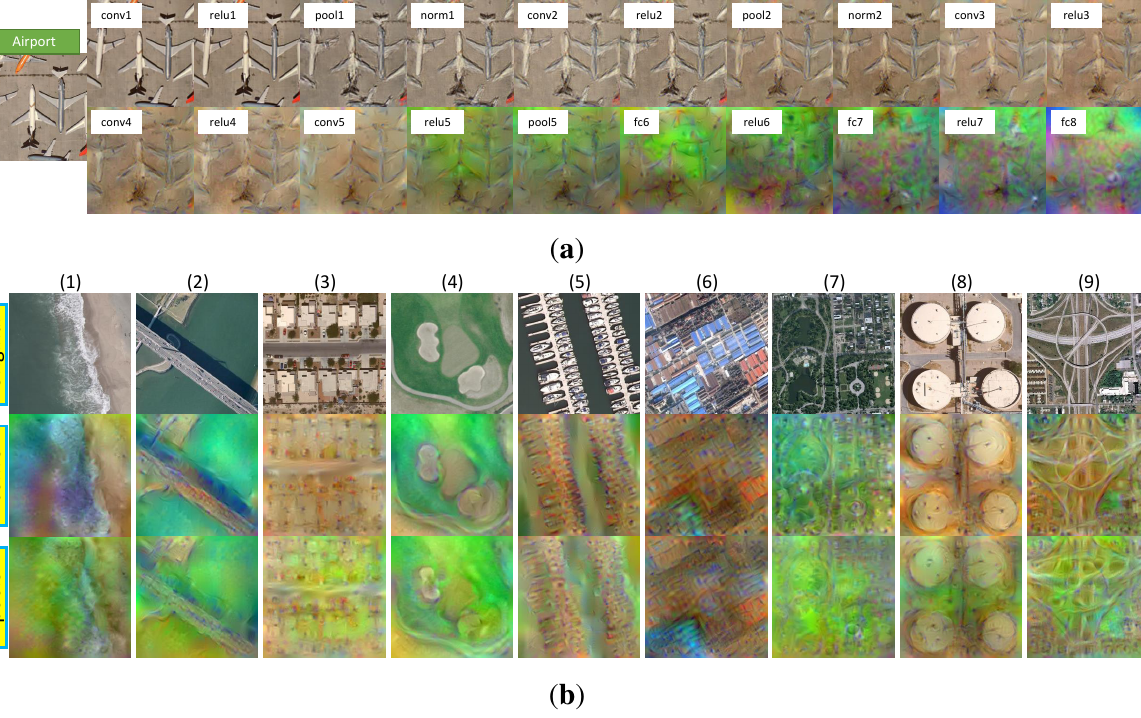
Figure 7. Reconstruction of CNN activations from different layers of AlexNet. The method presented in [58] is used for visualization. The reconstructed images lose more details increasingly along with deeper layers. ( a ) Reconstructed images from each layer of the AlexNet; Reconstructed images from each layer of the AlexNet; ( b ) More reconstruction examples of inverting CNN activations from the fifth convolutional and pooling